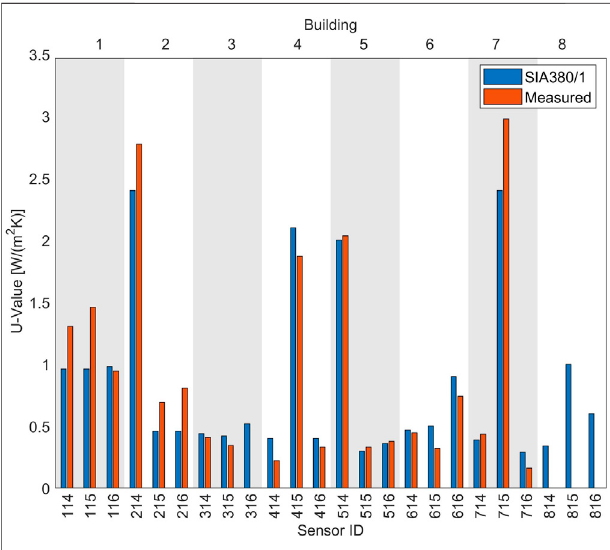
FIGURE 6 | Comparison ofmeasured U-values and U-values calculated according to SIA